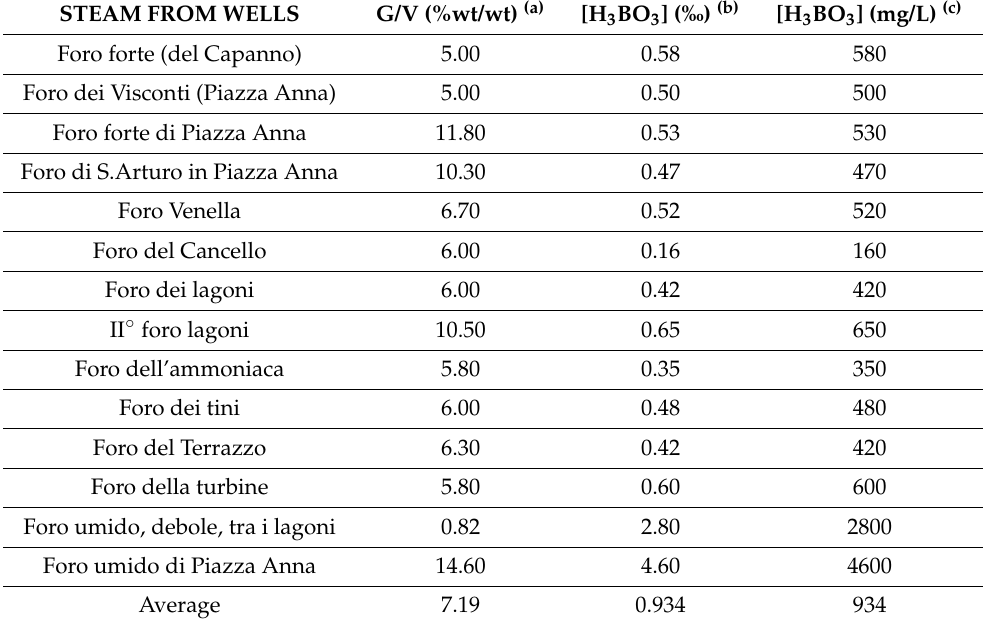
Table 2. Early steam characterization data according to ref. [39]. STEAM FROM